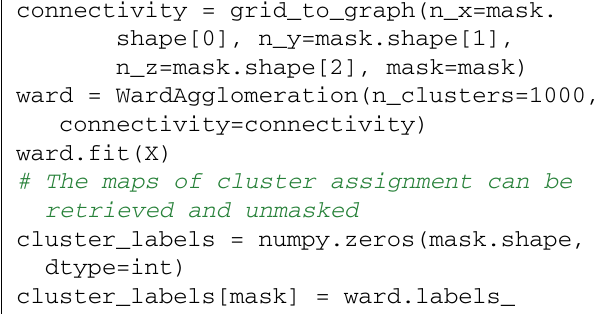
group voxels. So if the data matrix is, as previously a